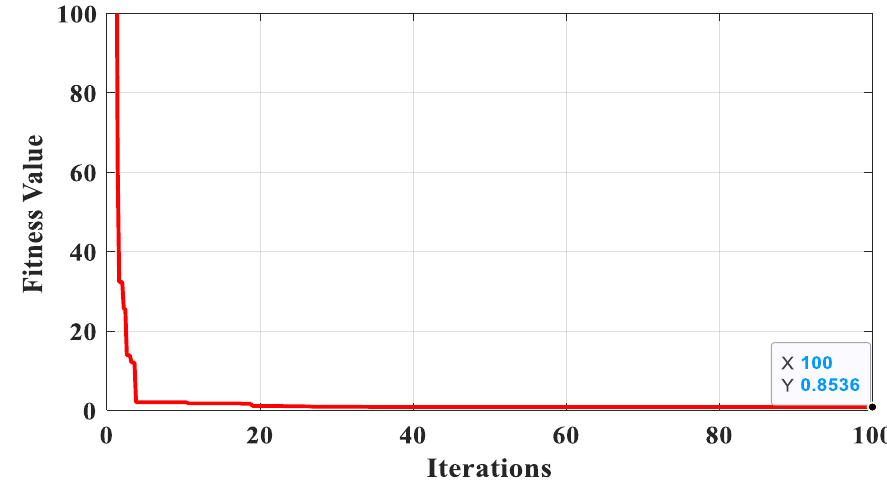
Figure 2. Convergence of the objective function of the Ballard PEMFC model. Table 1. Optimal parameters of the Ballard PEMFC model.